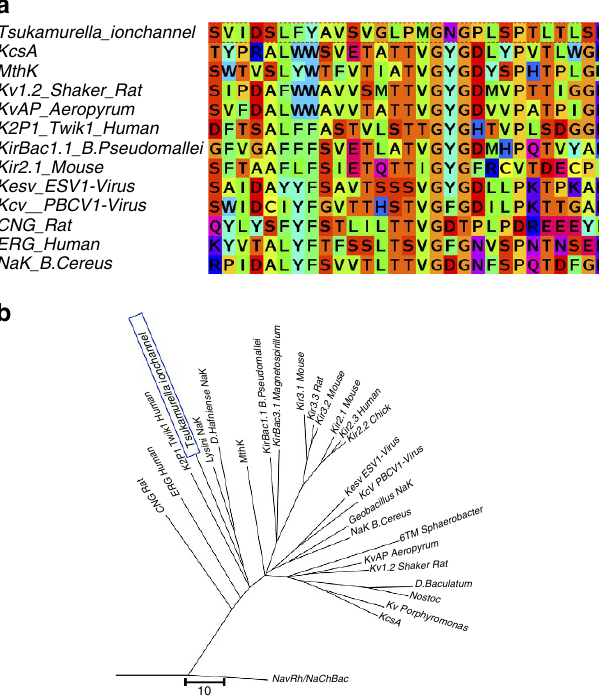
Figure 2 | X-ray crystal structure of the NaKTs ion channel determined at 3.15Å resolution. ( a ) Ribbon representation of top view of the NaKTs tetramer (chain ABDE—dataset 2), along with bound Ca 2 þ ions. The M0 helix (residues 5–19) is shown in blue, the M1 outer helix (residues 25–45) is shown in magenta, the pore helix (residues 46–61) is shown in green, the selectivity filter (residues 62–69) is shown in yellow, the M2 inner helix is shown in cyan and the loop regions are shown in green. Calcium ions are shown as purple spheres, with the 2 F o (cid:2) F c map (grey) at 1 s contour and F o (cid:2) F c map (green) at 4.5 s contour. ( b ) The TM region of two opposing monomers of the NaKTs ion channel protein (chain A, chain D) shown with the 2 F o (cid:2) F c density map at 1 s contour for the selectivity filter region (yellow sticks). ( c ) F o (cid:2) F c map (green) at 4.5 s contour and 2 F o (cid:2) F c map (grey) at 1 s contour showing the location of Ca 2 þ ion (purple sphere) at site S Ca . The pore helix (green cartoon), the selectivity filter residues (yellow sticks) and Ca 2 þ coordinating AA’s are labelled accordingly. ( d ) Close-up view of two opposing monomers of the NaKTs selectivity filter (chain A, chain D) shown in yellow sticks with bound Ca 2 þ ions at sites S2 and S Ca